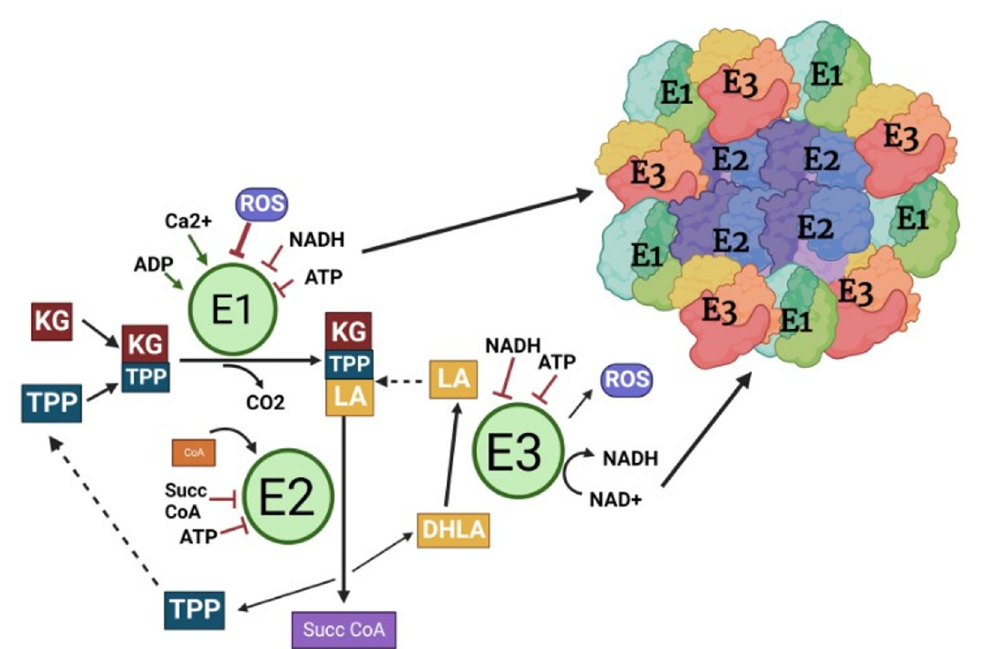
Figure 2. Structure and function of the α -ketoglutarate dehydrogenase complex (KGDHC). KGDHC is made up of three subunits. E1k, E2k, and E3. The core of KGDHC is com-posed of E2k proteins surrounded by E1k and E3 subunits forming an octahedral cube. This complex catalyzes the conversion of α -ketoglutarate (KG) to succinyl-CoA. KG combines with thiamine pyrophosphate (TPP) to enter the E1 subunit. This complex interacts with lipoic acid and E2k produces succinyl-CoA. Lipoic acid is reduced to dihydrolipoic acid (DHLA), which is oxidized by the E3 subunit to lipoic acid. Each subunit of KGDHC is uniquely regulated. Further, the E3 subunit produces ROS and the E1 subunit is inhibited by reactive oxygen species (ROS).